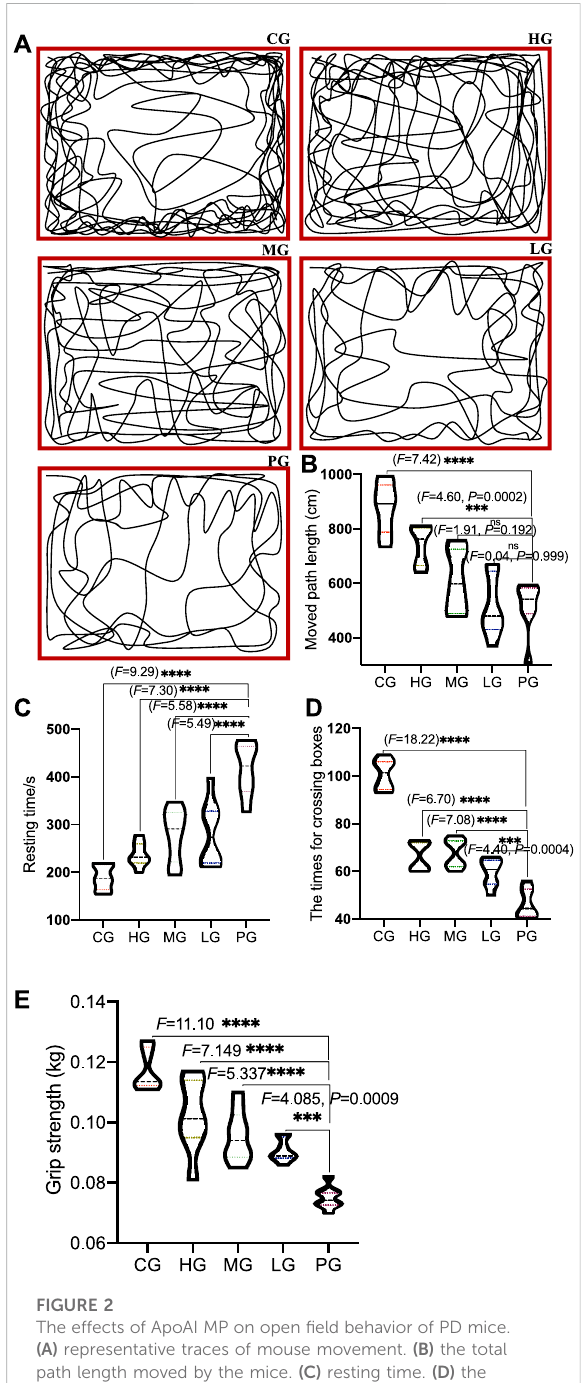
The effects of ApoAI MP on open fi eld behavior of PD mice. (A) representative traces of mouse movement. (B) the total path length moved by the mice. (C) resting time. (D) the number of passing boxes. (E) grip strength. N = 8 for in each group. ns P > 0.05, *** p < 0.001 and **** p < 0.0001 vs. the PG